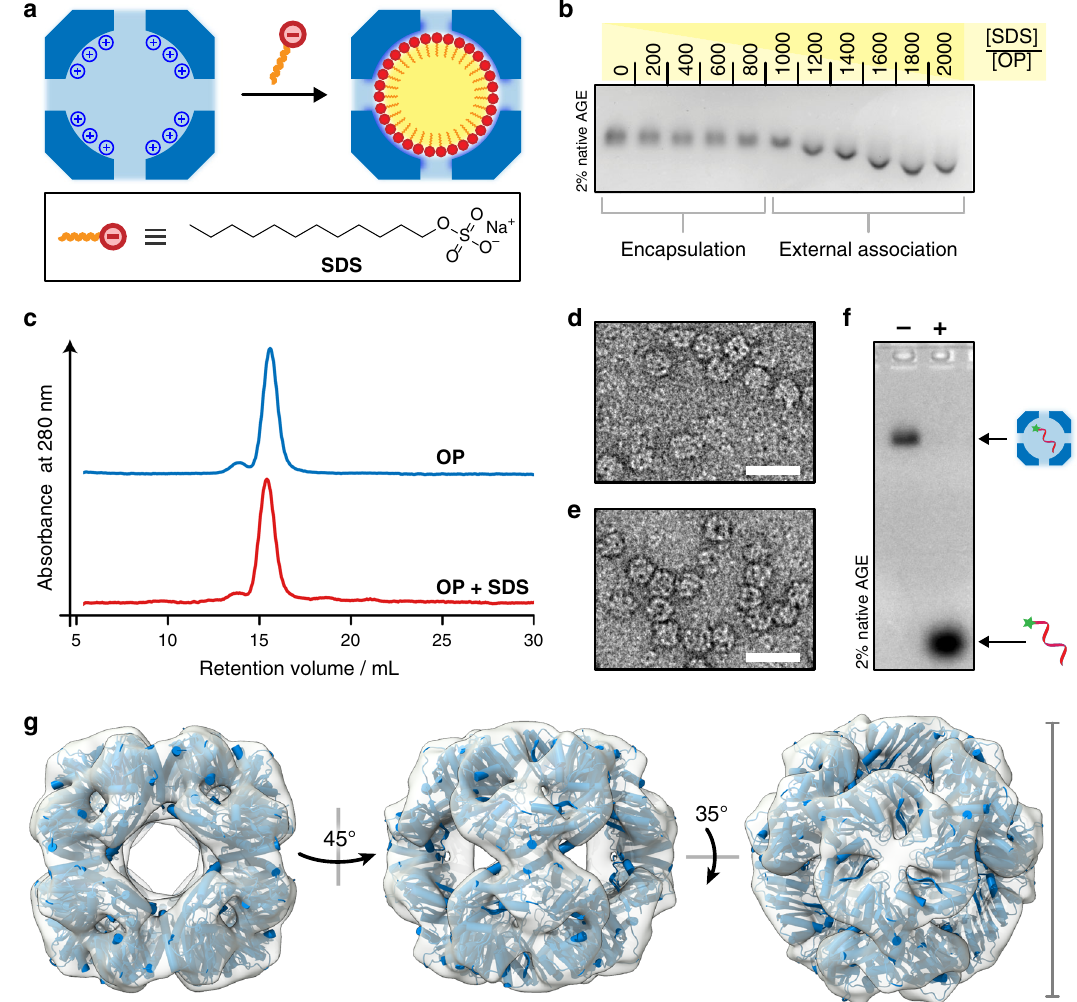
Fig. 2 Capsid-templated micelle formation. a Cartoon depiction of protein cage-templated micellization of sodium dodecyl sulfate (SDS) molecules. b Native gel electrophoresis of the OP cage in the presence of increasing molar equivalents of SDS. c Size-exclusion chromatography of the OP cage before and after incubation with 800 equivalents of SDS. d Transmission electron micrograph of empty OP cages and e OP cages in the presence of SDS (800 equiv.); scale bars are 30 nm. f Encapsulation of fl uorophore-labeled ssDNA visualized by native gel electrophoresis. In the absence of SDS ( − ) the OP cage internalizes the ssDNA probe quantitatively. After internalization of the SDS molecules ( + ) the OP cage can no longer encapsulate the oligonucleotide probe. g 3D volumes determined by cryo-EM for OP:SDS (transparent surface) overlaid onto the crystal structure (blue ribbons and cylinders, PDB: 6FDB) show that the protein cage structure is retained. Scale bar = 13 nm. Source data are provided as a Source Data